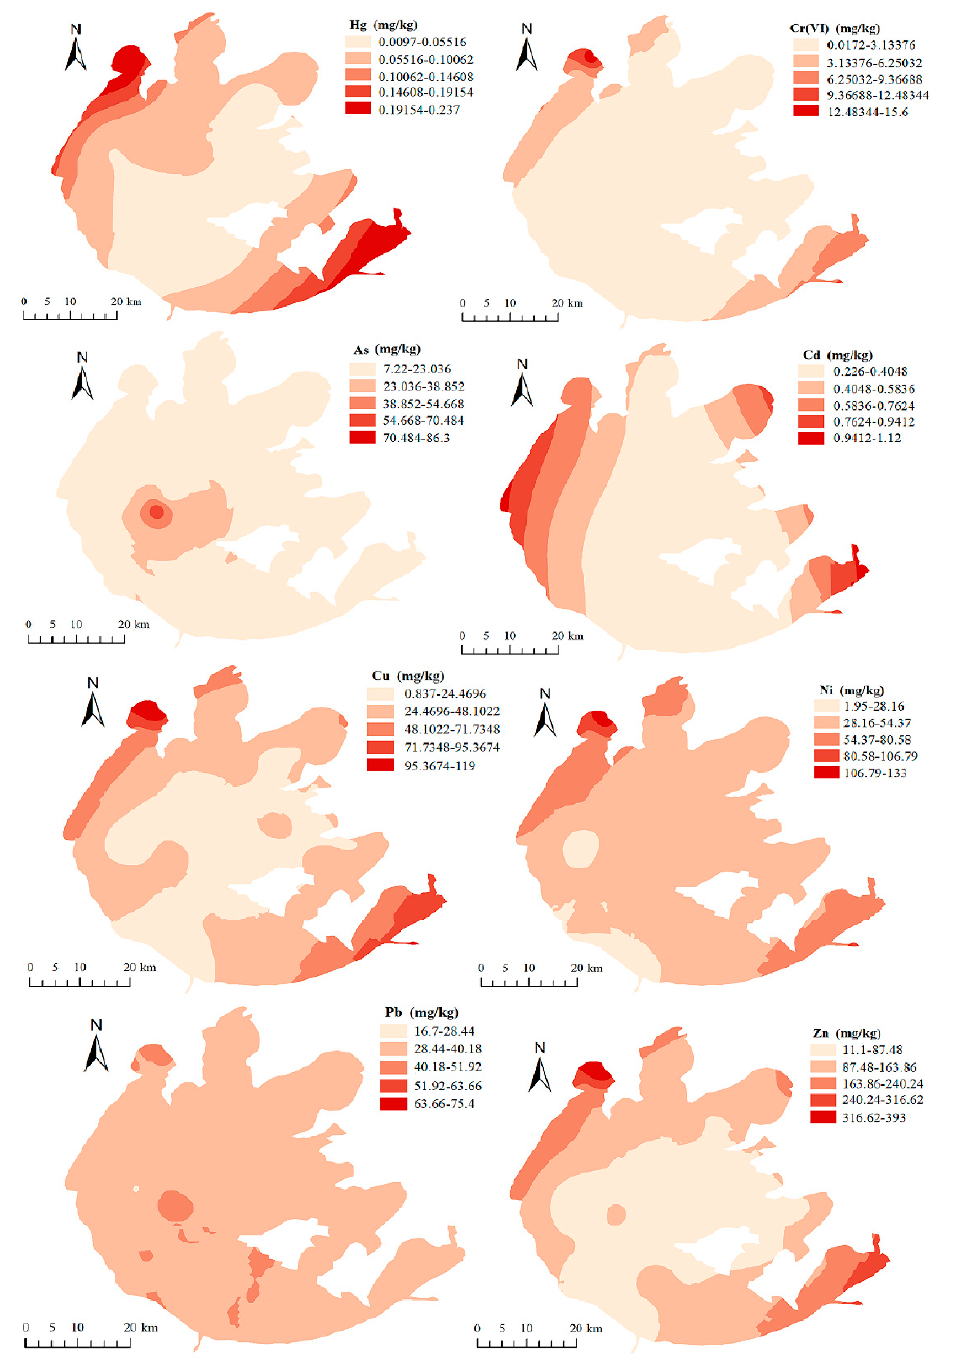
Figure 3. Spatial distributions of heavy metals in the sediments of Taihu Lake.